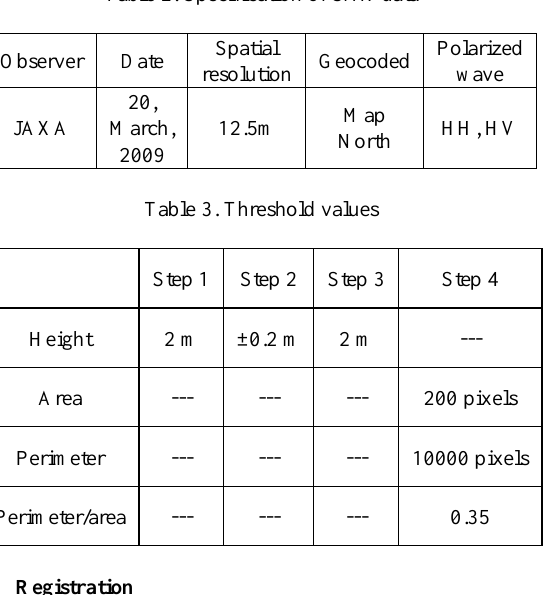
Table 2. Specification of SAR data